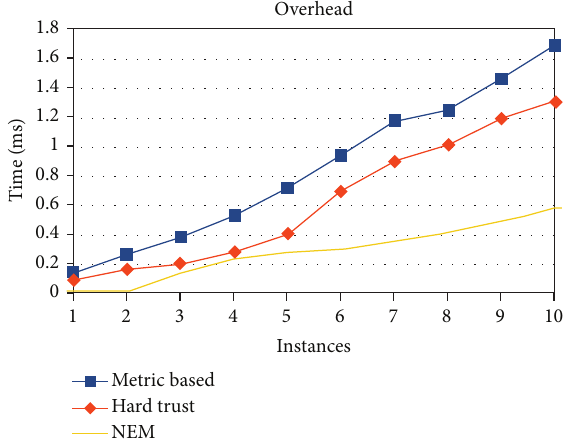
Figure 9: Trusted resources error in percentage